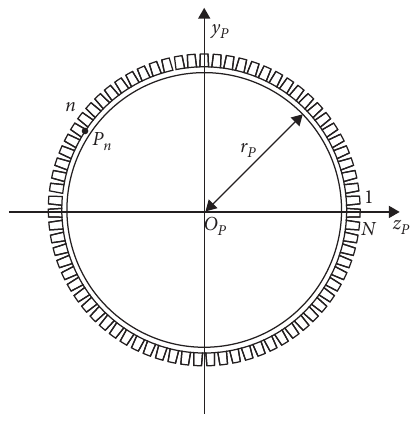
Figure 3: The schematic diagram of the AAT.